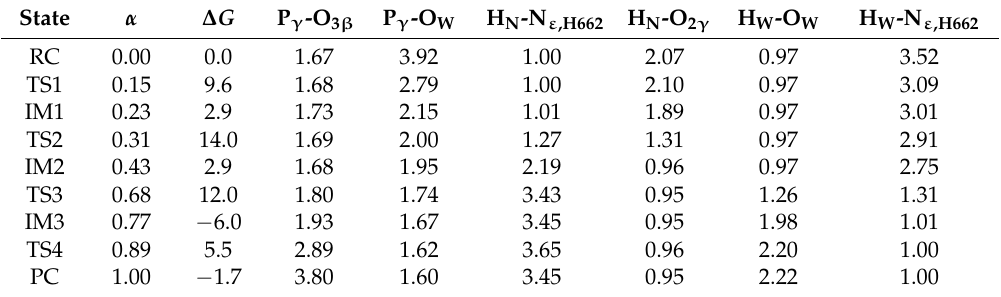
Table 1. Free energies (in kcal/mol) and collective variables (in Å) of the stationary states on the MFEP obtained for the GAC mechanism.